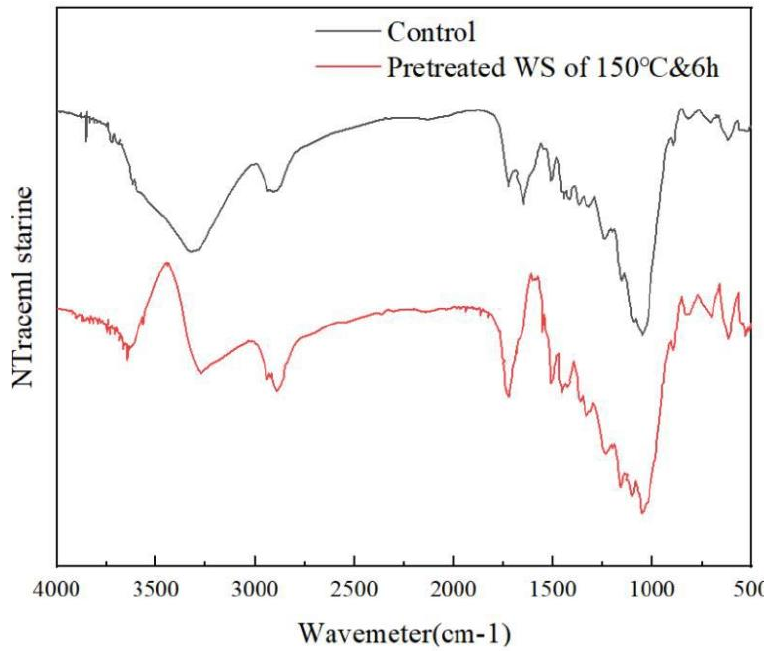
Figure 6. FTIR spectra of untreated and DES-pretreated wheat straw.